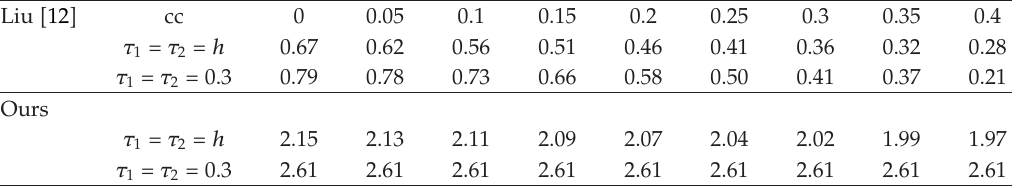
Table 3: Calculated allowable size of distributed delay h (cid:2)Δ A (cid:2) t (cid:3) (cid:9) Δ B (cid:2) t (cid:3) (cid:9) Δ D (cid:2) t (cid:3) (cid:9) 0 (cid:3) (cid:2) Example 4.3 (cid:3) . Liu (cid:4) 12 (cid:5)